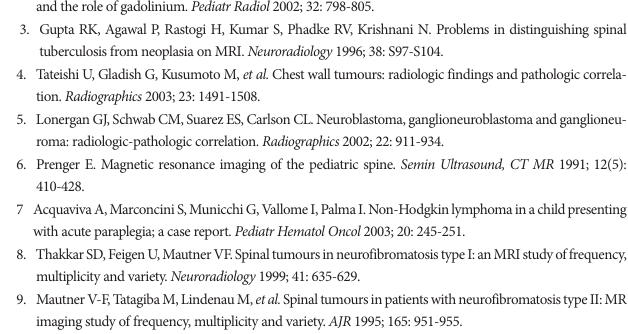
tuberculosis from neoplasia on MRI. Neuroradiology 1996; 38: S97-S104. 4. Tateishi U, Gladish G, Kusumoto M, et al. Chest wall tumours: radiologic findings and pathologic correla- tion. Radiographics 2003; 23: 1491-1508. 5. Lonergan GJ, Schwab CM, Suarez ES, Carlson CL. Neuroblastoma, ganglioneuroblastoma and